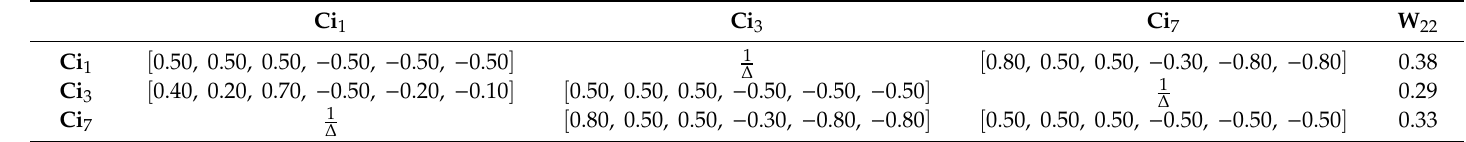
Table 10. Interior interdependencies matrix of factor C 5 .